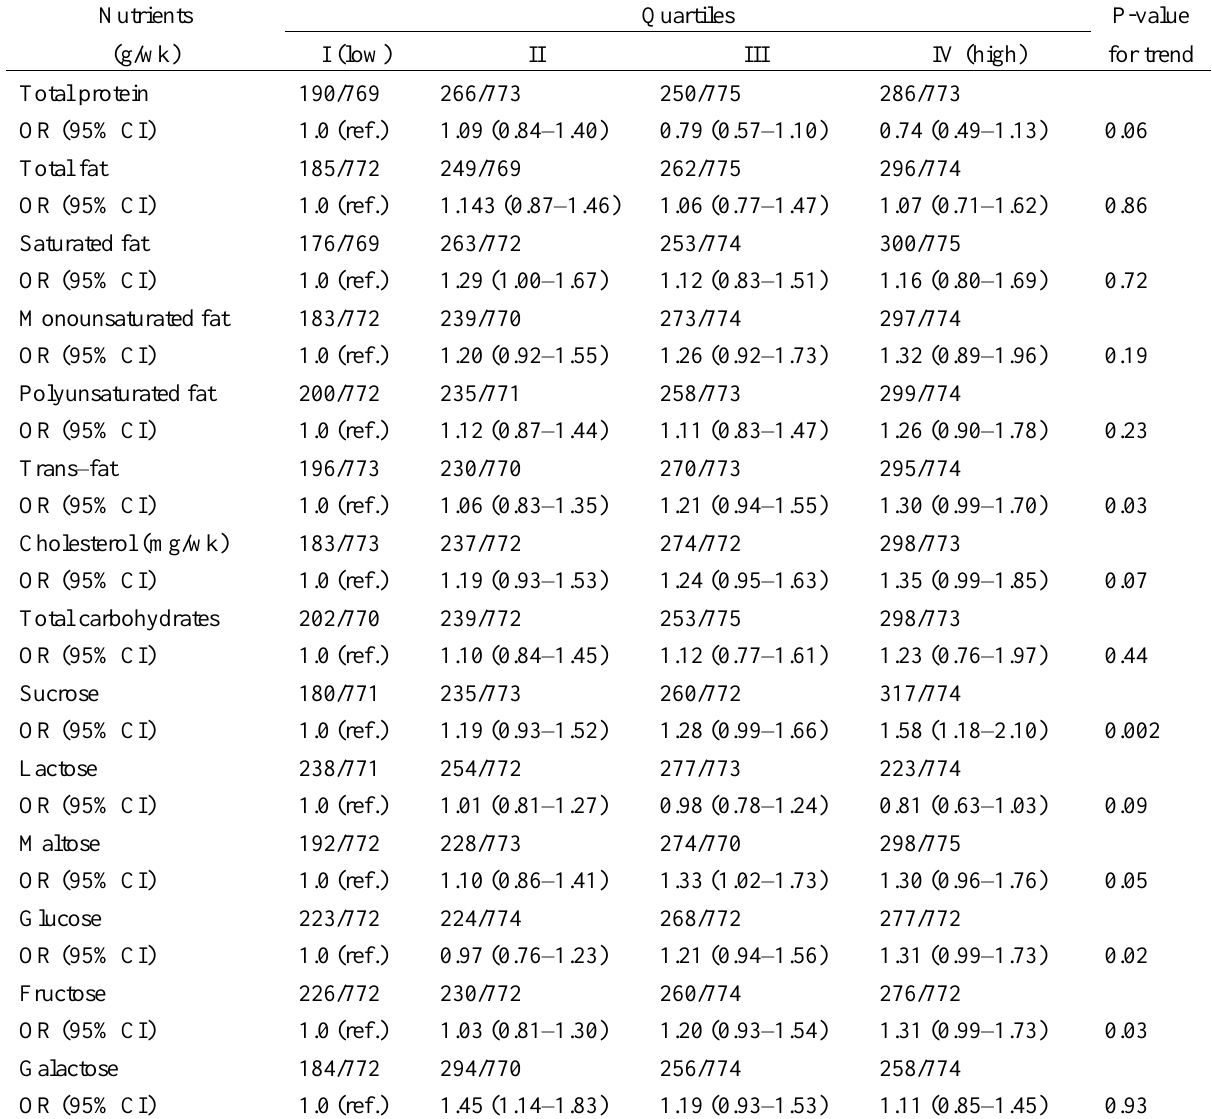
Table 4. Odds ratios* and 95% confidence intervals of fats, protein, cholesterol carbohydrates for distal colon cancer, NECSS, Canada,